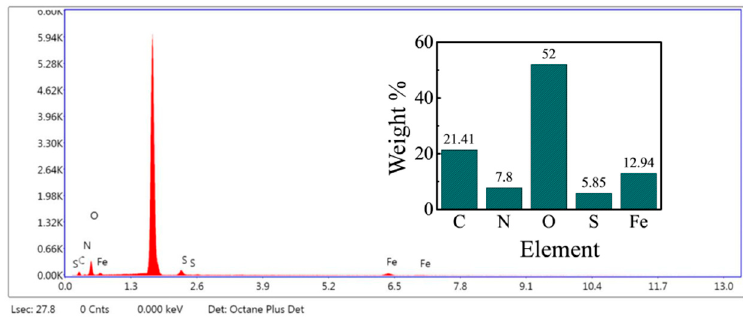
Figure 6. EDX analysis of the Fe 3 O 4 -PDA-SO 3 H.